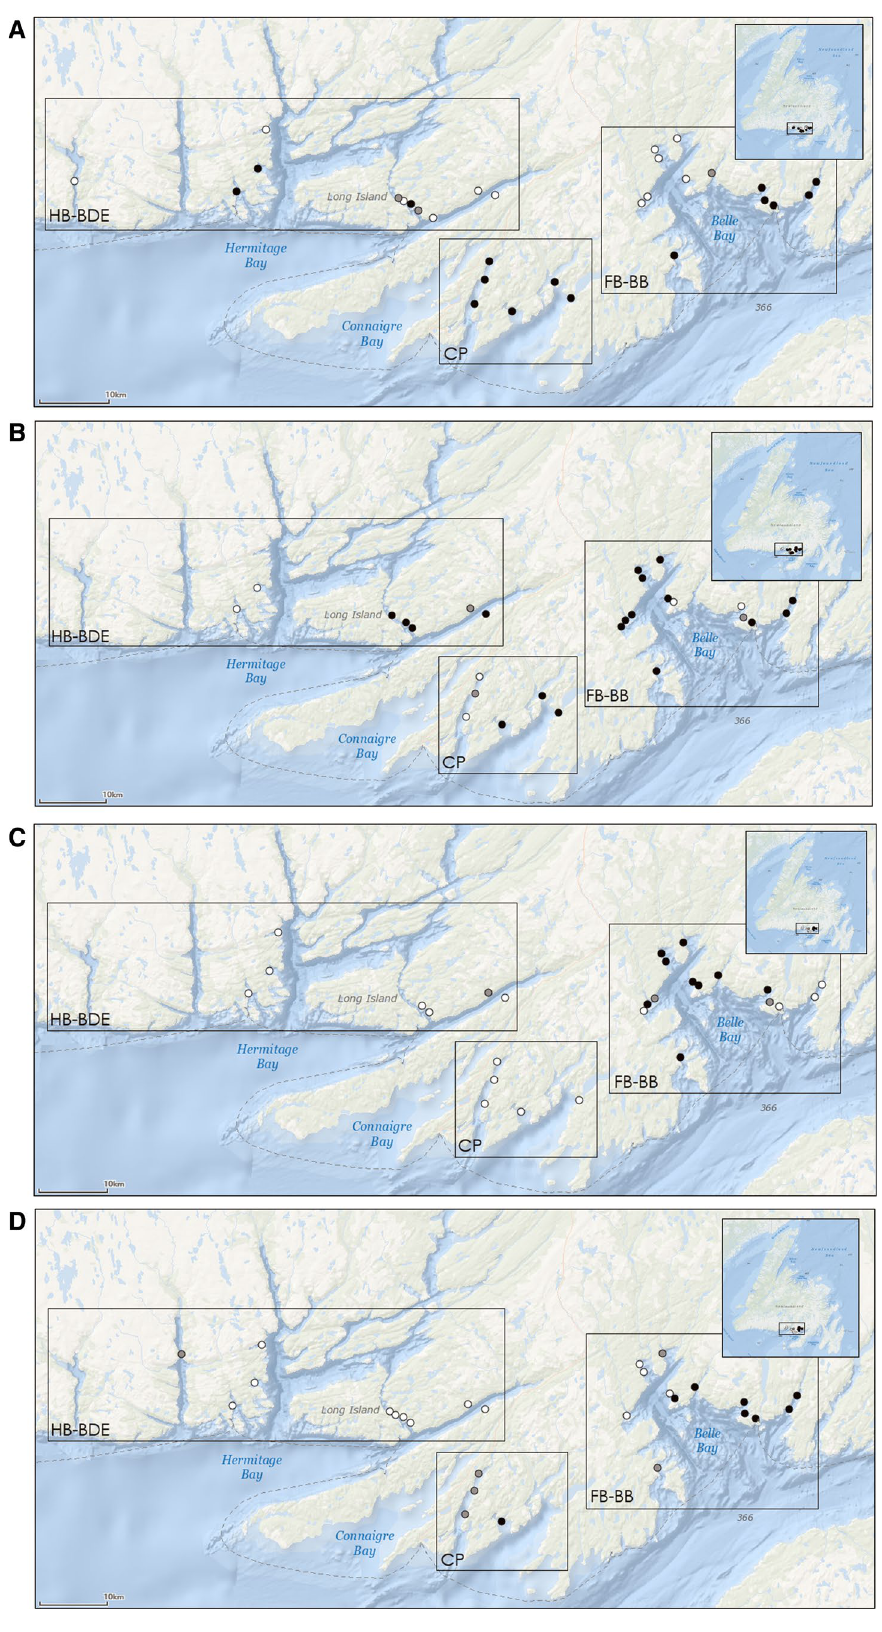
Figure 1. Location of all active sites on the South Coast of NL in 2016 ( A ), 2017 ( B ), 2018 ( C ), and 2019 ( D ). White dots indicate active sites with no treatments. Light grey dots indicate locations of lower anti-sea lice chemicals usage and black dots of higher usage as per DTA analyses of site usage for 4 years. Black boxes indicate bay areas as defined by 1 day water connectivity patterns 20 . FB-BB: Fortune Bay—Belle-Bay; HB-BDE: Hermitage Bay—Bay d’Espoir; CP: Connaigre